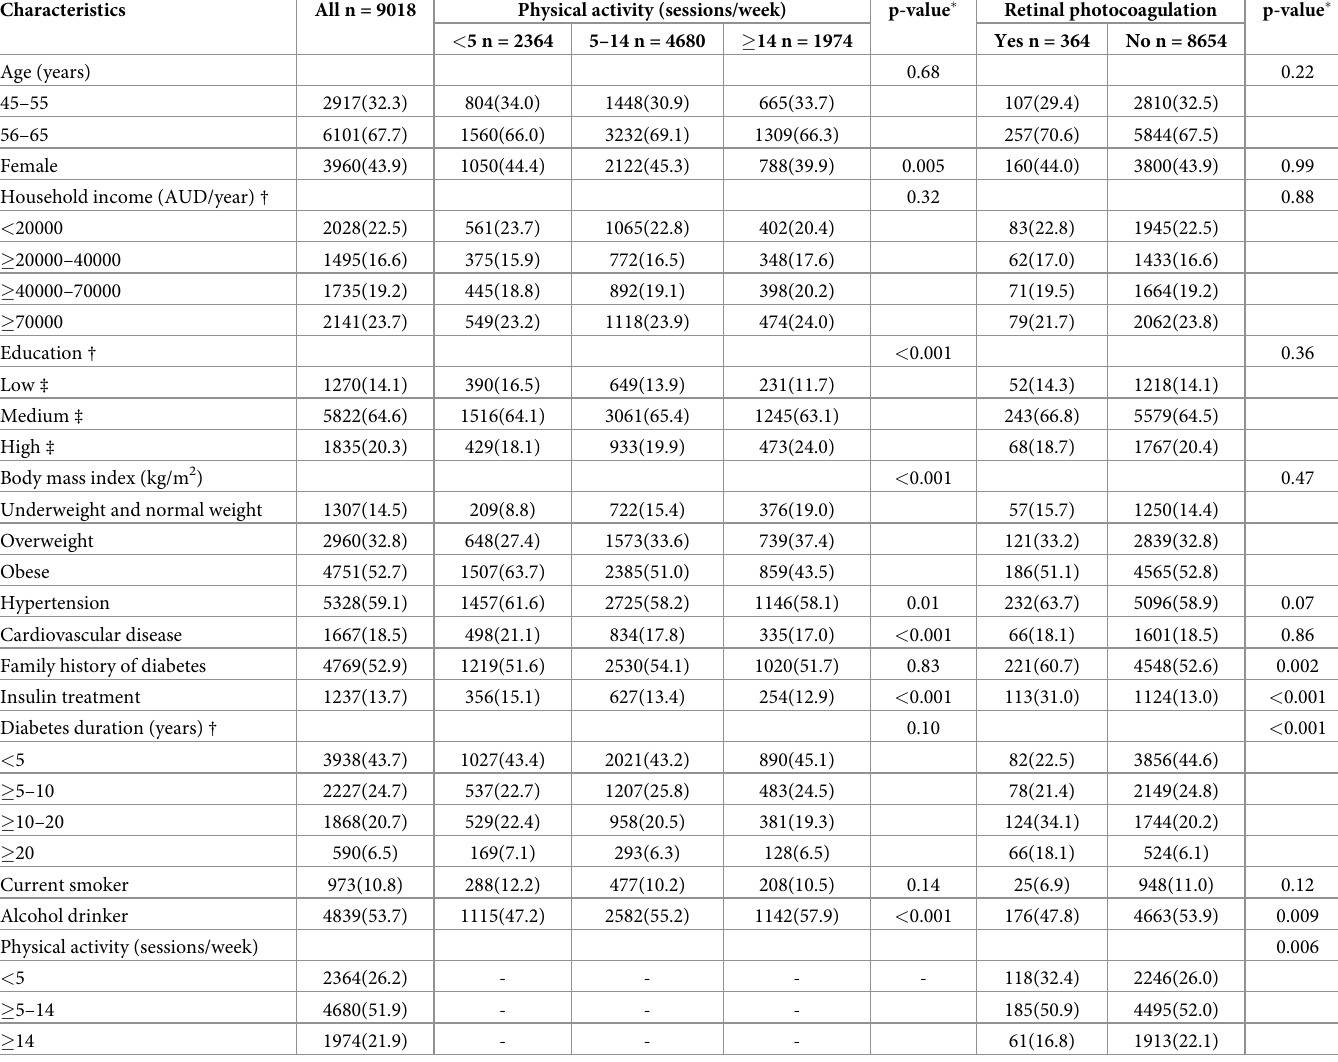
Table 1. Comparison of baseline characteristics among participants with different physical activity levels and between participants who did and did not receive reti- nal photocoagulation during the follow-up period.